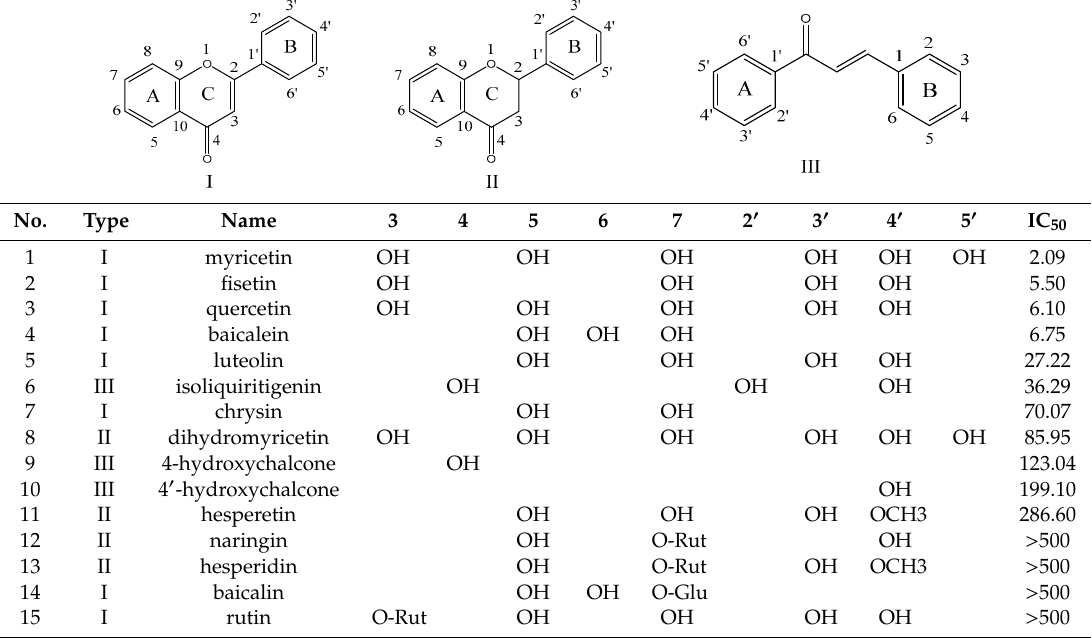
Table 1. The chemical structures and IC 50 values ( µ g / mL) of 15 flavonoids.